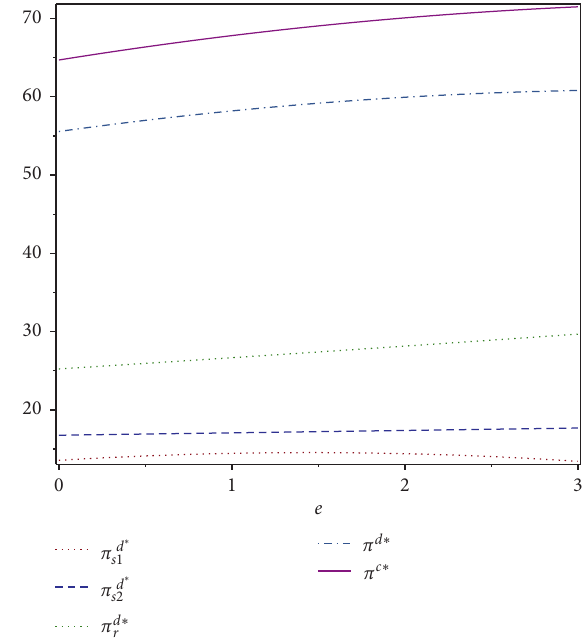
Figure 2: The influence of cooperation effort degrees on